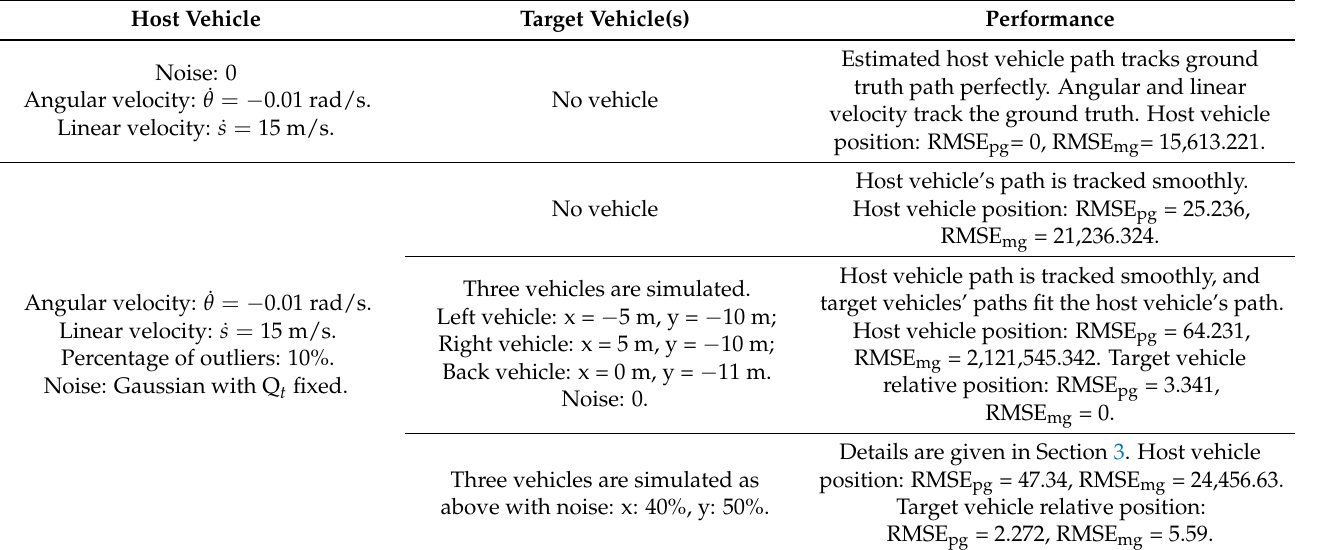
Table 2. Experiment II (trajectory estimation in simulation) results. RMSE pg compares predicted values to ground truth, RMSE mg compares raw observations to ground truth.